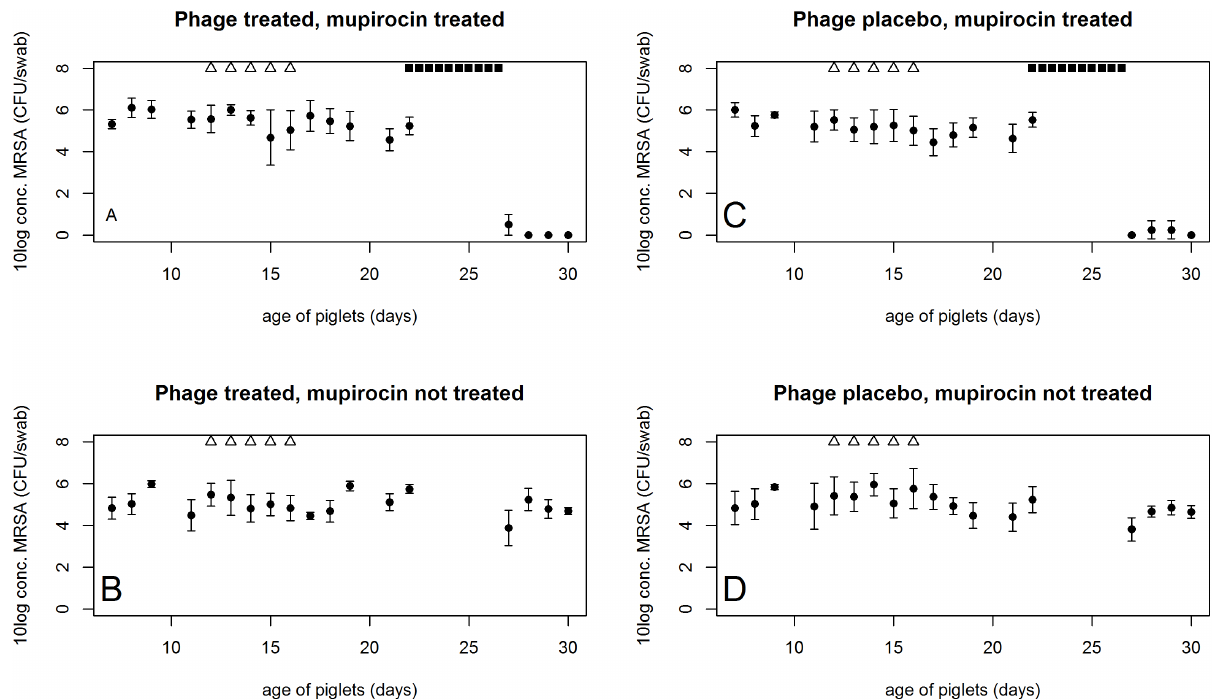
Fig 2. MRSA recovery in the in vivo experiment. Culture results for nasal samples in the in vivo experiment. Numbers of MRSA are displayed in CFU/swab. The error bars represent standard deviation. Each group consisted of 4 piglets. Group A) piglets that were treated with bacteriophage solution and received mupirocin ointment; B) piglets that received a placebo without bacteriophage and were treated with mupirocin ointment; group C) received a bacteriophage treatment, but no mupirocin and group D) was administered a placebo without bacteriophage and was not treated with mupirocin. 4 ) indicate bacteriophage or placebo treatment; ■ ) indicate ointment with mupirocin. If a sample was obtained on the same day as treatment took place the sample was taken before treatment was applied.